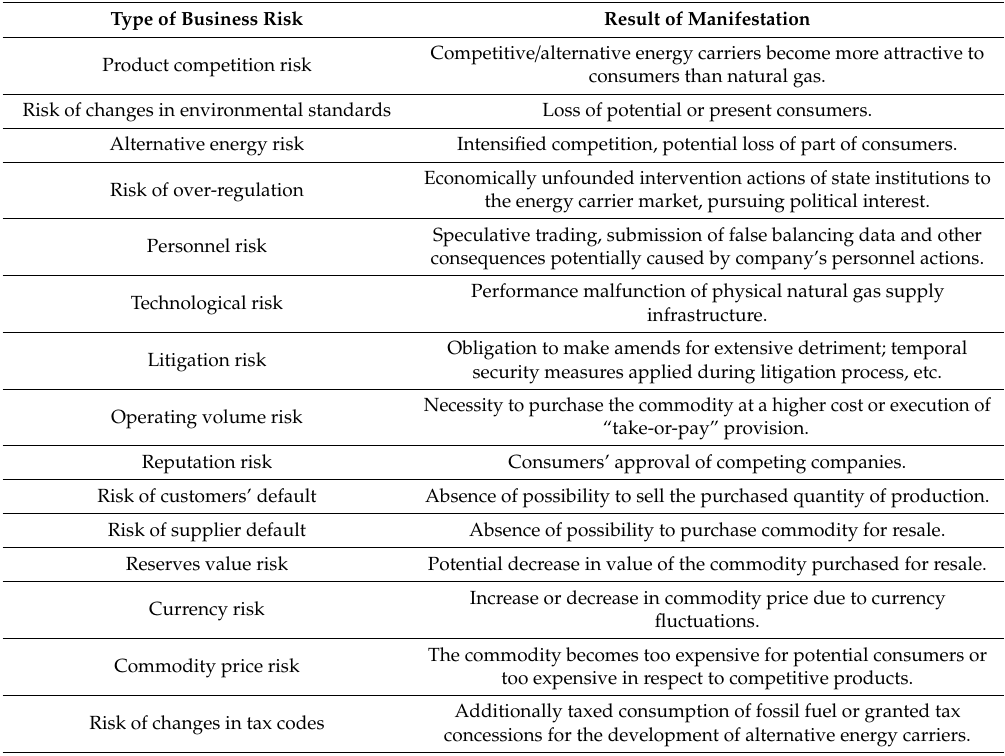
Table 1. Business risks a ff ecting natural gas trading companies.